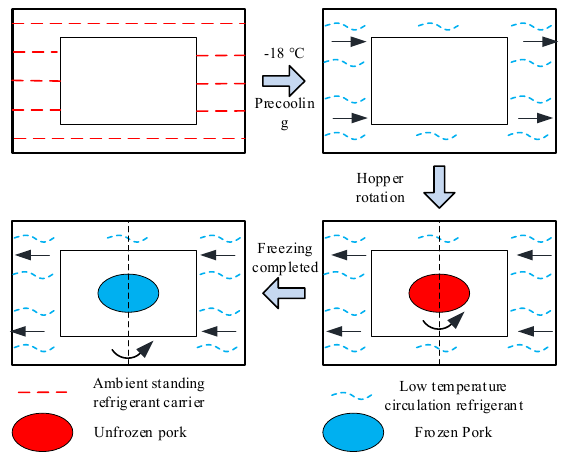
Figure 3. Working principle diagram of improved impregnation refrigeration equipment.